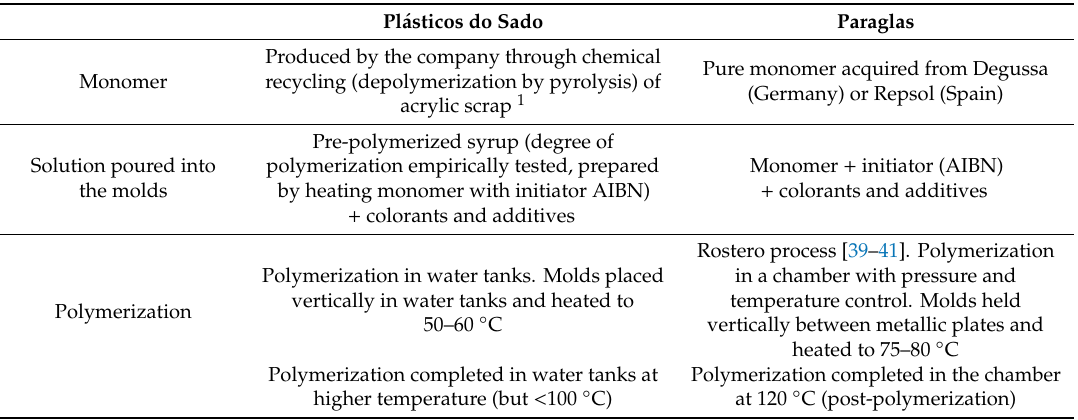
Table 1. Main characteristics of the production of poly(methyl methacrylate) (PMMA) sheets in the two di ff erent plants (adapted from